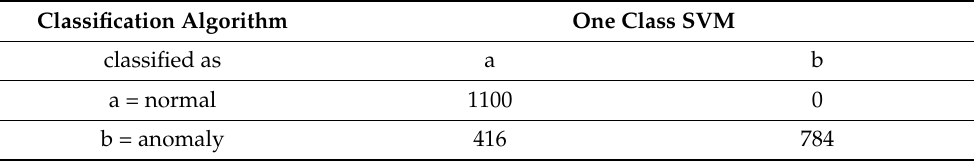
Table 9. Confusion matrix for one-class SVM.